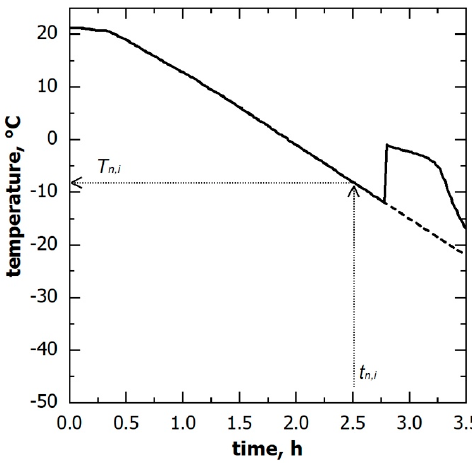
Figure 3. Temperature evolution of the solution being frozen, as observed through thermocouples; (solid line) the measured signal and (dashed line) the profile used to derive the nucleation temperature distribution. A corresponding nucleation temperature ( 𝑇 (cid:3041),(cid:3036) ) can be identified for each ice nucleation time ( 𝑡 (cid:3041),(cid:3036) ) observed in a non-monitored vial. The nucleation temperature distributions in the case of various cooling rates are compared in Figure 4. Although the nucleation time distributions varied with this parameter, the cumulative distribution of the nucleation temperature was independent of the cooling rate, at least in the range of 0.25 to 0.5 °C min − 1 . Within this range of conditions, these results suggest that the ice nucleation temperature distribution can be considered independent of the cooling rate used. Figure 4. Cumulative distribution for the ice nucleation temperature in the case of vials in direct contact with the shelf. Data refer to various cooling rates: ( ▲ ) 0.25, ( □ ) 0.50, and ( ● ) 1.00 °C min − 1 . On the contrary, at the highest cooling rate, i.e., 1 °C min − 1 , a significant fraction of vials (approximately 30%) nucleated below − 25 °C, although the median nucleation temperature remained unvaried. This result was consistent with the spread of nucleation temperature data, (cid:4666)𝑇 (cid:2869)(cid:2868) − 𝑇 (cid:2877)(cid:2868) (cid:4667) and T IQR . Therefore, pronounced vial-to-vial variability in freezing behaviour and, hence, product morphology is expected in the case of a cooling